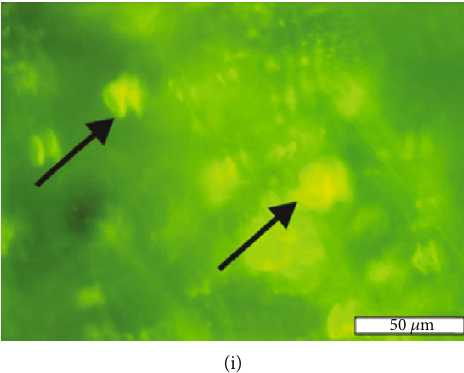
Figure 7: Characteristics of fl uid inclusions in minerals fi lling in anhydrite dissolution pores in Yican 1. (a) Two-phase liquid-vaporous inclusions (WL+V) in calcite fi lling in anhydrite dissolution pores corresponding to Figures 4(j) and 4(k), 2640.9m, Ma 51 , sample 90. (b) Two-phase liquid-vaporous inclusions (WL+V) in calcite fi lling in anhydrite dissolution pores corresponding to Figure 4(i), 2642.5m, sample 96. (c) Two-phase liquid-vaporous inclusions (WL+V) in calcite fi lling in anhydrite dissolution pores, 2641.8m, sample 94. (d) Two-phase hydrocarbon inclusions of calcite fi lled in fracture showing light brown (OL) and black color (OV) in transmission light, 2642.5m, sample 96. (e, f) Vaporous hydrocarbon inclusions (OV) of calcite showing black color in transmission light, 2635m, sample 73. (g) Two-phase hydrocarbon inclusions of calcite fi lled in fracture showing light yellow (OV) and no fl uorescence light (OV) in ultraviolet fl uorescence light (the same thin section of (d)), 2642.5m, sample 96. (h) Liquid hydrocarbon (OL) in the dolomite at the bottom of mold showing light green color in ultraviolet fl uorescence light, 2641.8m, sample 94. (i) Vaporous hydrocarbon inclusions (OV) of calcite showing yellow color in ultraviolet fl uorescence light (the same thin section of (f)), 2635m. Table 1: Homogenization temperature of fl uid inclusions in minerals fi lling in anhydrite dissolution pores in Yican 1 of the southeastern Ordos Basin.